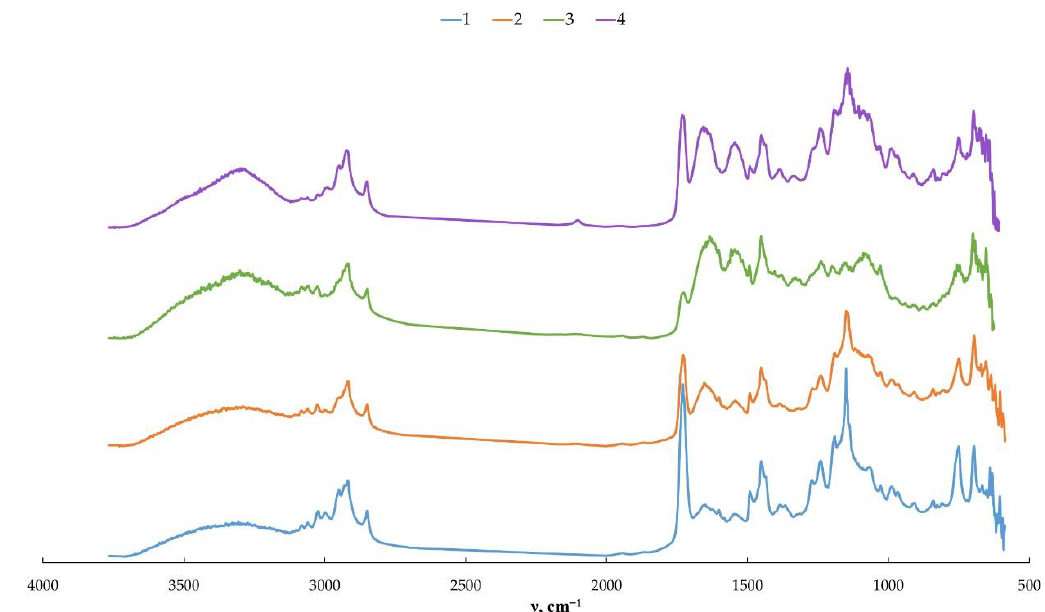
Figure 2. IR spectra of Gel-PMMA copolymers obtained in the presence of ( 1 ) AIBN, TBB, and 2,5-